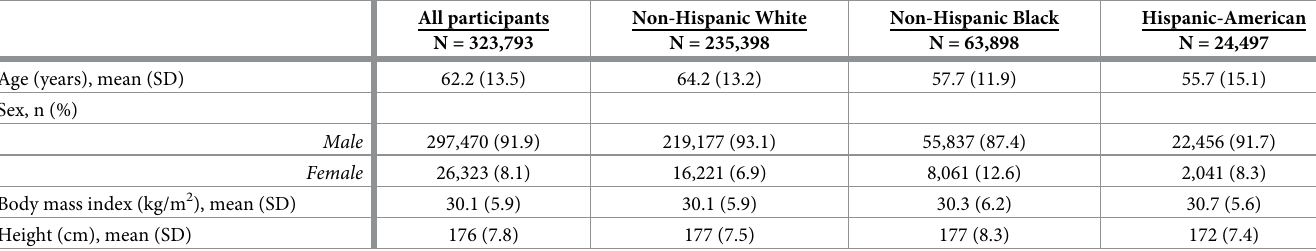
Table 1. Study participant